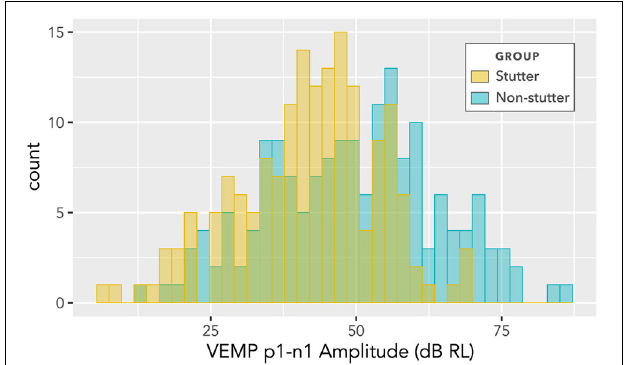
FIGURE 6 | Histogram of VEMP p1-n1 amplitudes for stutter and control groups. The histogram does not show detail of participant or stimulus level, and contains repeated measurements for the two groups of 15 participants per group. As such, it suggests shape of distribution and direction of group difference, but is not appropriate for statistical comparison (statistical comparison is by linear mixed-effects regression modelling).